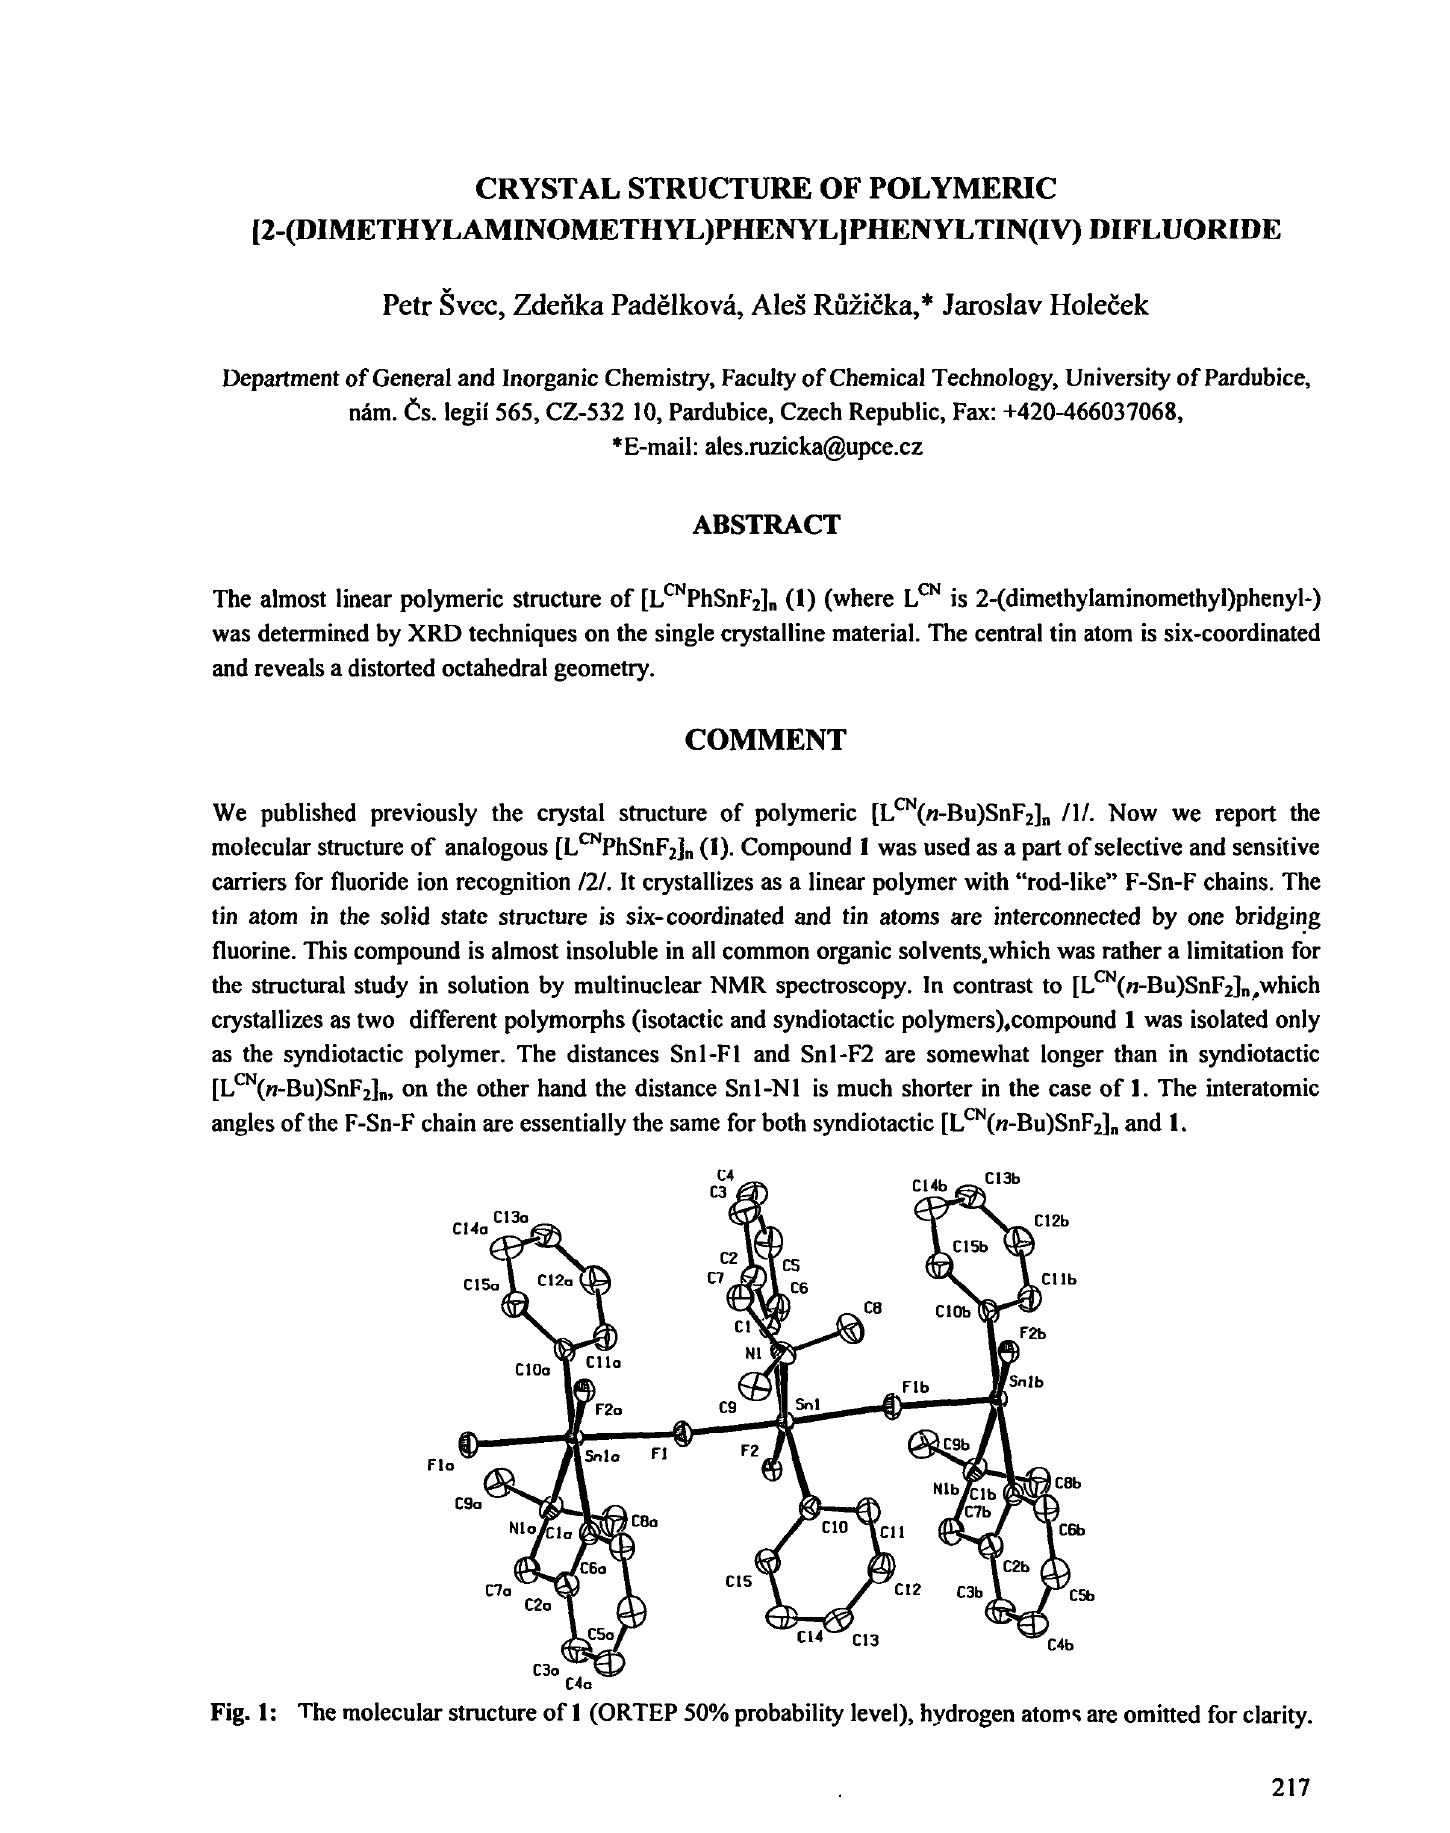
Fig. 1: The molecular structure of 1 (ORTEP 50% probability level), hydrogen atoms are omitted for clarity.